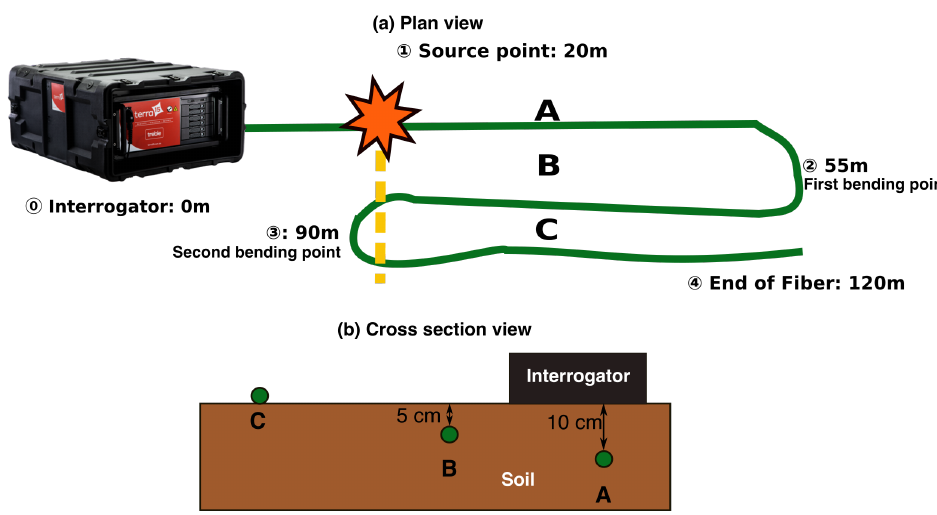
Figure 1. Schematic drawing of DAS acquisition geometry in plan ( a ) and cross-sectional ( b ) view. Sections A and B correspond to the trenched fiber locations at approximately 10 cm and 5 cm depth, respectively (see lower panel). The fiber in Section C is laid on top of the ground. In this layout, sections A–C respectively are between 20–55 m, 55–90 m, and 90–120 m in the along-fiber distance. The orange star and yellow dashed line indicates the source point at 20